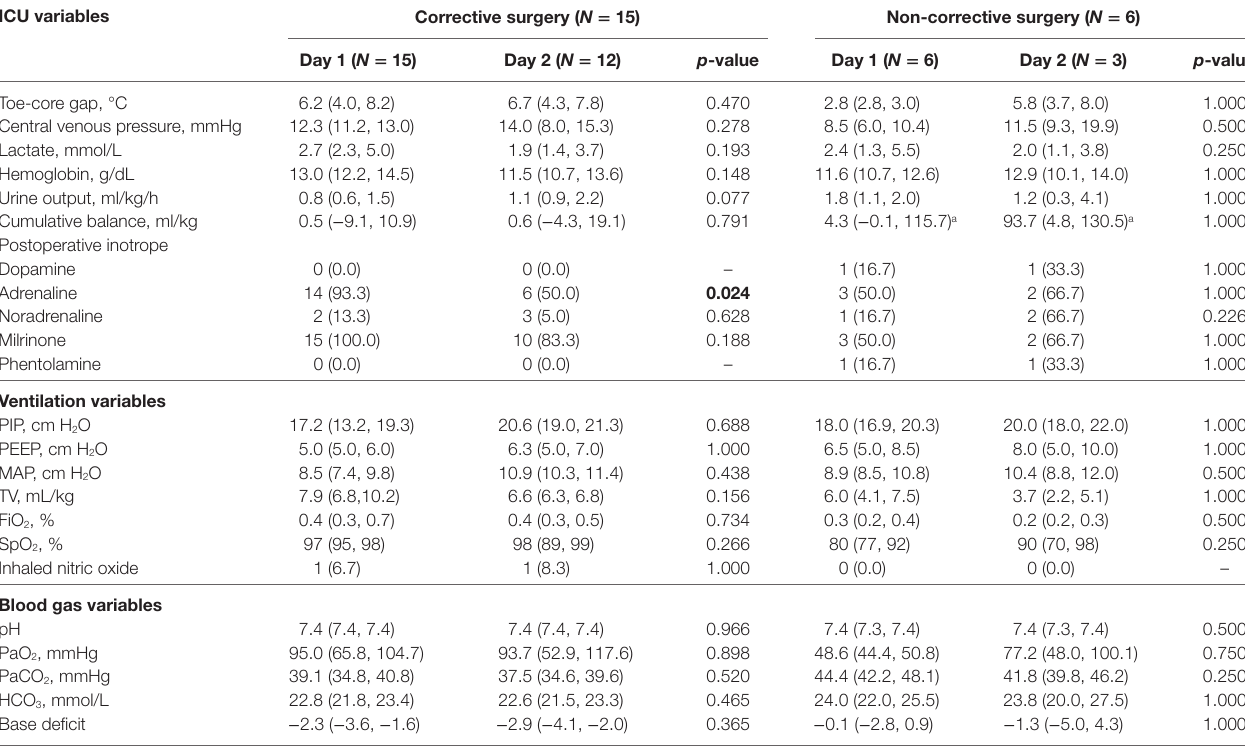
TaBle 3 | Summary of intensive care unit (ICU) variables ( N = 21).